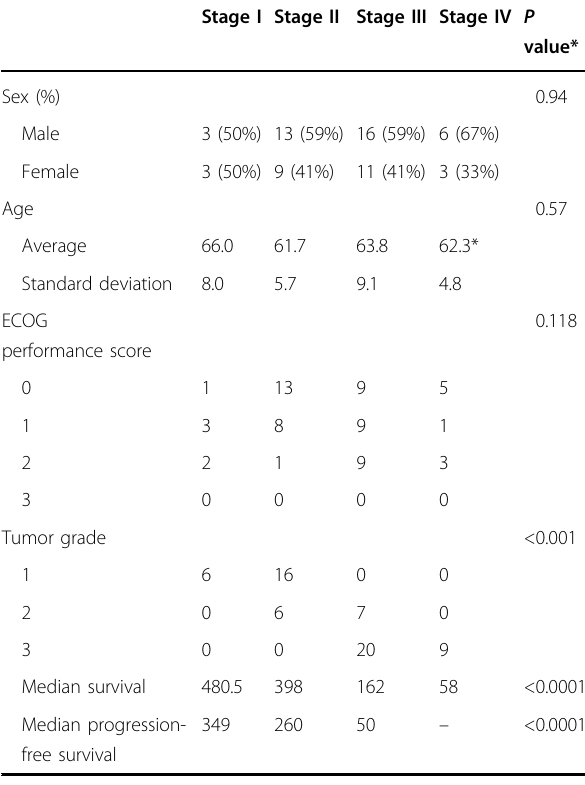
Table 2 Patient baseline characteristics (one-way ANOVA, chi-square test, * P <